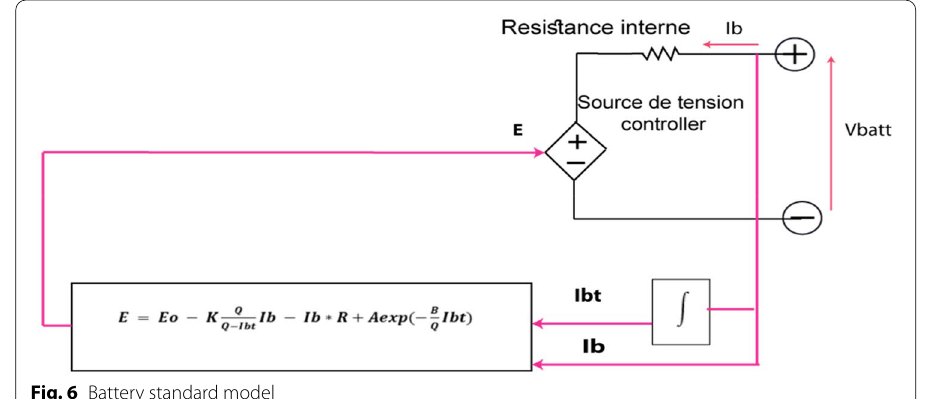
Fig. 6 Battery standard model